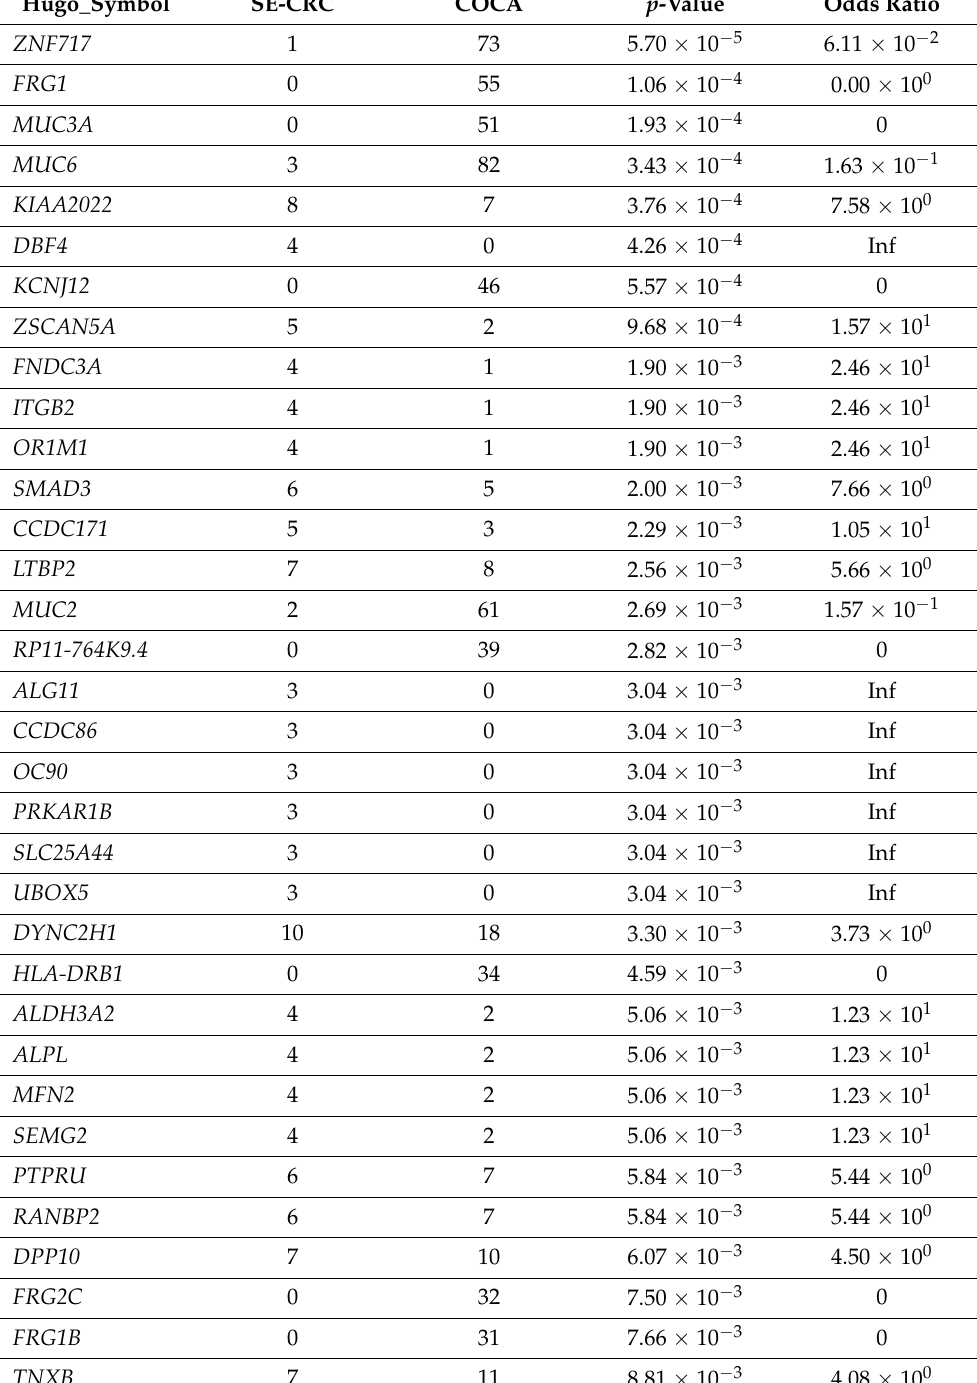
Table 2. Fisher’s exact test results of the comparison of CRCs from our cohort with COCA and TCGA ( p < 0.01).